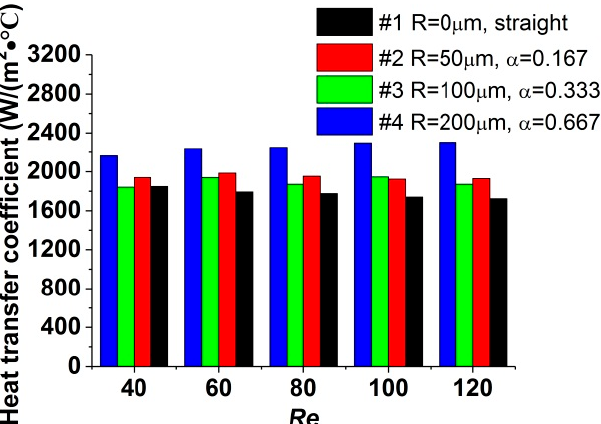
Figure 4. Influence of 𝛼 on heat-transfer coefficient.